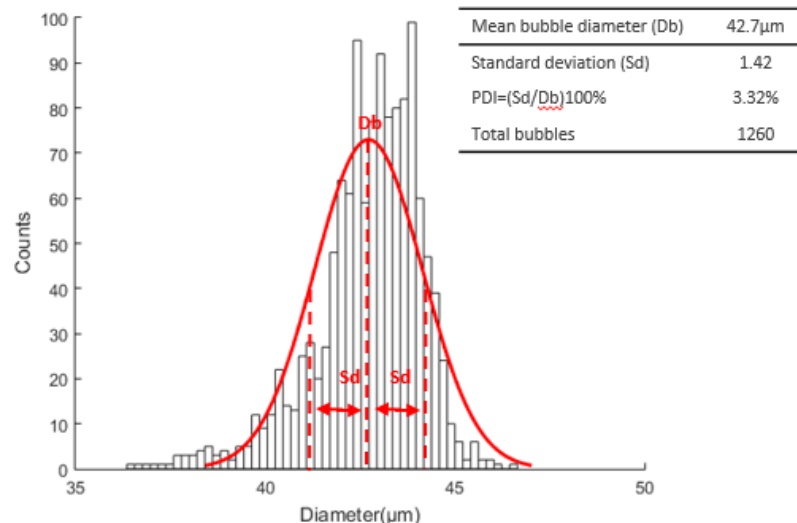
Figure 15. Microbubble diameter distribution curve with a mean diameter, standard deviation, and PDI of 42.7 μm, 1.42 , and 3.32%, respectively.